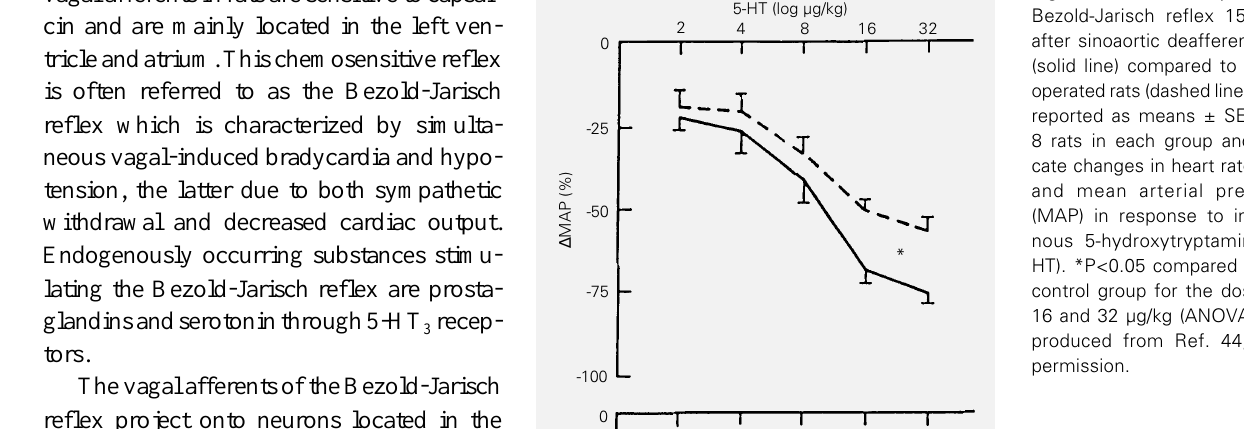
Figure 3 - Sensitivity of the Bezold-Jarisch reflex 15 days after sinoaortic deafferentation (solid line) compared to sham- operated rats (dashed line). Data reported as means – SEM for 8 rats in each group and indi- cate changes in heart rate (HR) and mean arterial pressure (MAP) in response to intrave- nous 5-hydroxytryptamine (5- HT). *P<0.05 compared to the control group for the doses of 16 and 32 (cid:181)g/kg (ANOVA). Re- produced from Ref. 44, with